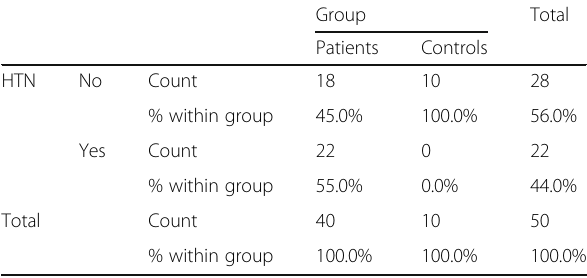
Table 3 Comparing the studied groups regarding the history